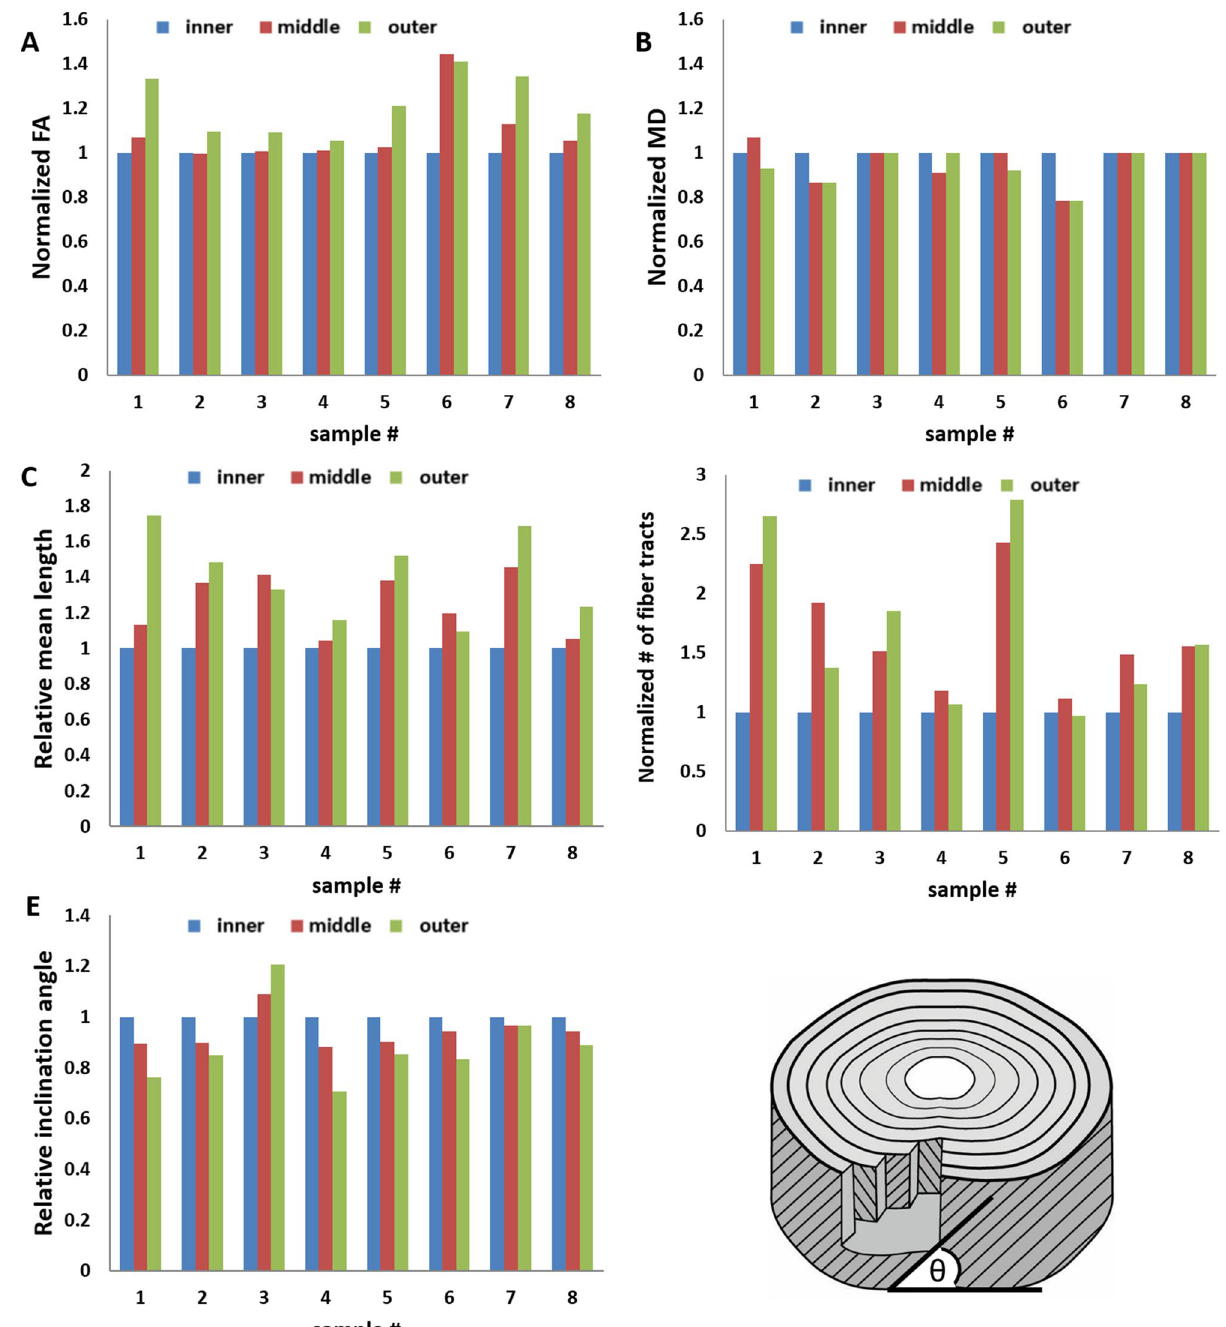
Figure 4. Diffusion and morphological parameters for the eight samples, normalized to the inner aspect. FA tends to increase from the inner to the outer region ( A ), whereas MD shows only a little variation among the regions ( B ). The mean fiber tracts’ length in each of the three regions after normalization to the length of the inner region ( C ). The inner region has the lowest fiber tract length throughout all the samples. In six out of the eight samples, the outer aspect of the disc has the largest mean fiber tract length. The number of fiber tracts found is higher in the outer region in four samples and is higher in the middle region in four other samples ( D ). The peaks of the axial inclination angle to the axial plane from the disc surface follow a steady pattern in seven out of the eight samples scanned, in which the highest peak appears in the inner region and decreases from there toward the outer aspects of the disc ( E ). P value < 0.001 between any two regions tested for each sample (t test), apart from MD differences, which did not show significant variations between